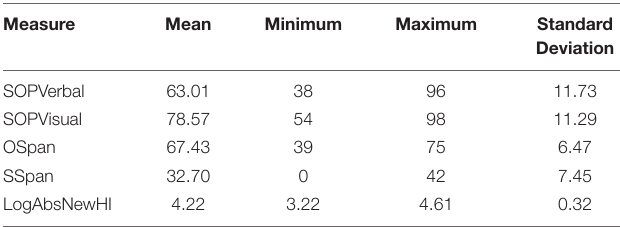
TABLE 2 | Mean, Minimum, Maximum, and Standard Deviation Values for Each of the Five (SOPVerbal and SOPVisual for SOP) Individual Difference Measures of Chinese